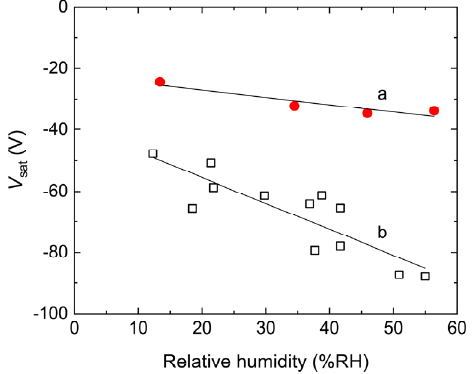
Figure 10. Plot of V sat versus relative humidity for layered ( a ) and single-layer ( b ) films with an average doping level of 1 wt% P25.